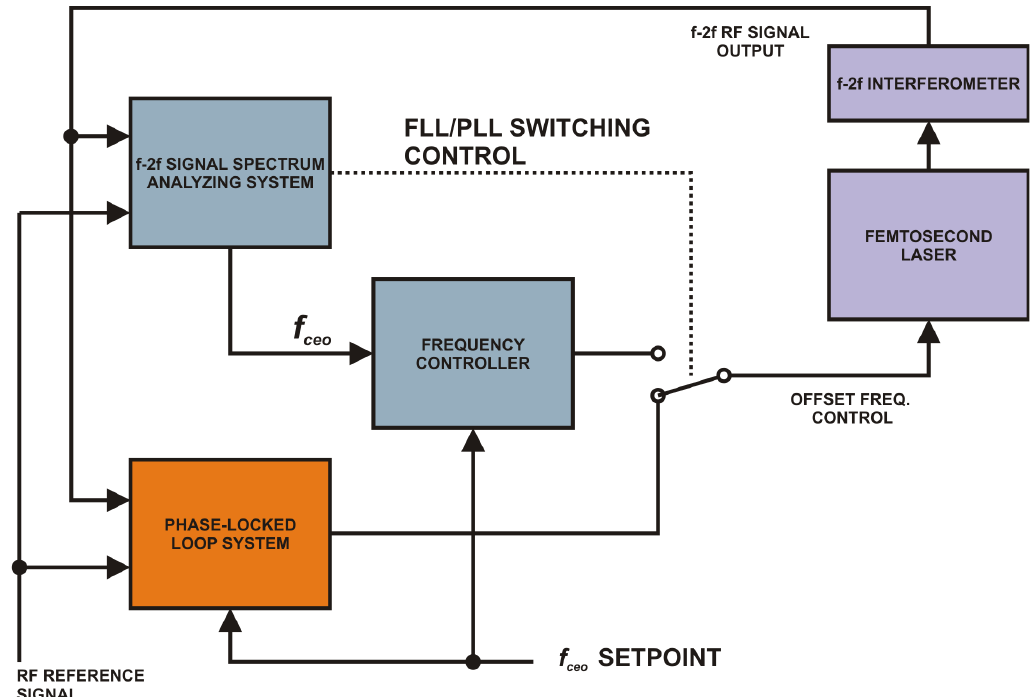
Figure 5. The block schematics of the system for a long-term stabilization of the offset frequency of the optical frequency